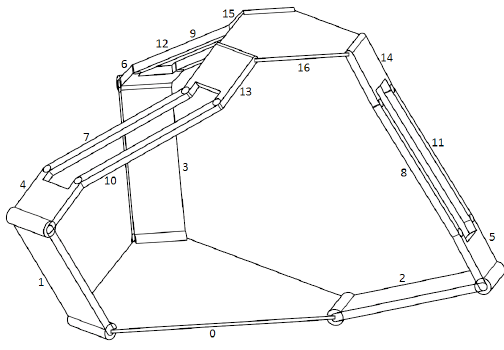
Figure 2: Mechanical schematic of the Novint Falcon ’s robotic configuration There are four links in each of the three kinematic chains. The first link in each chain (links 1, 2, and 3) is Figure 2. Mechanical schematic of the Novint Falcon’s robotic configuration. connected to the stationary platform, equally spaced from the other two lowest links. The next four links form a parallelogram connected to the moving platform. The four‐bar parallelogram consists of links (4, 7, 10, 13) for the first chain, (5, 8, 11, 14) for the second chain, and (6, 9, 12, 15) for the third chain. The three parallelograms are connected to the moving platform with equal spacing.